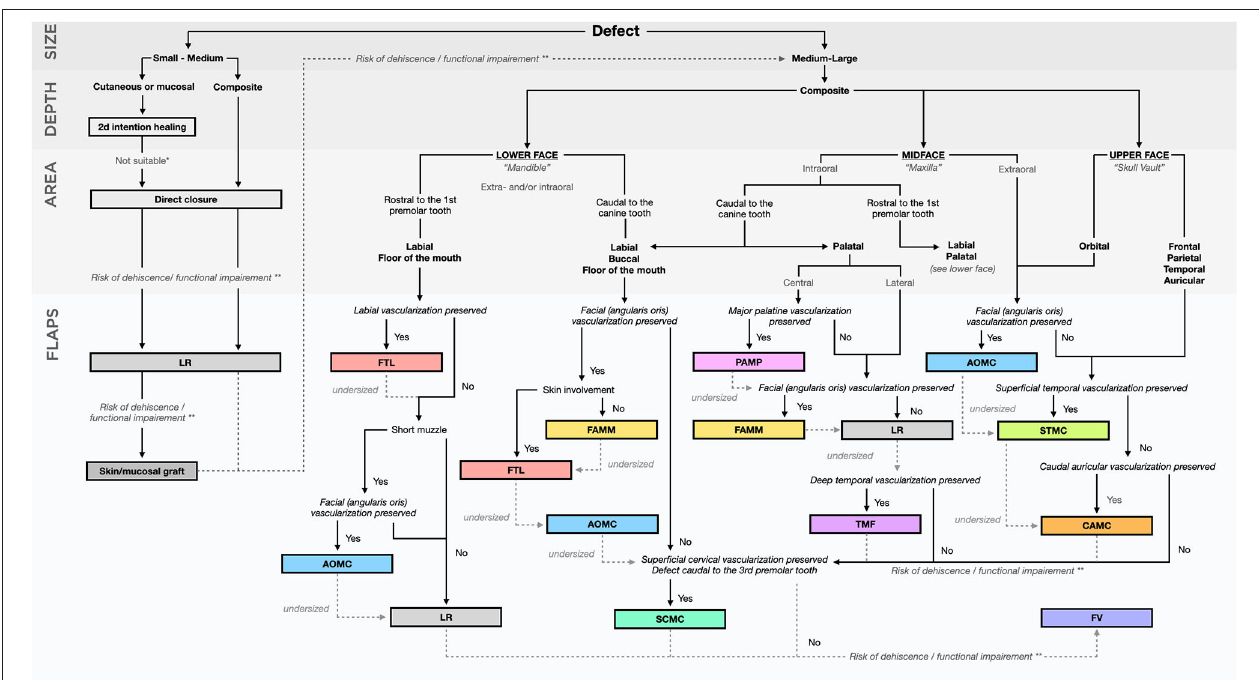
FIGURE 15 | Decisional algorithm. *e.g., risk of periorbicular fibrosis/retraction, infection, bone exposure. **e.g., risk of oronasal communication, occlusal trauma, inability to eat, wound dehiscence, upper airways